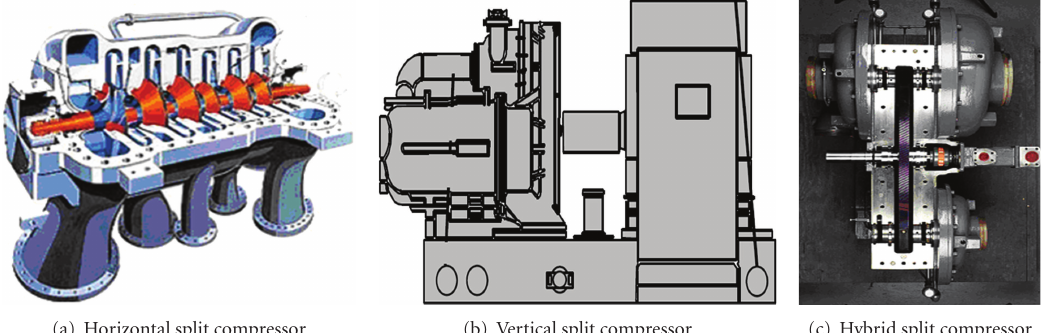
Figure 1: Compressor split types.